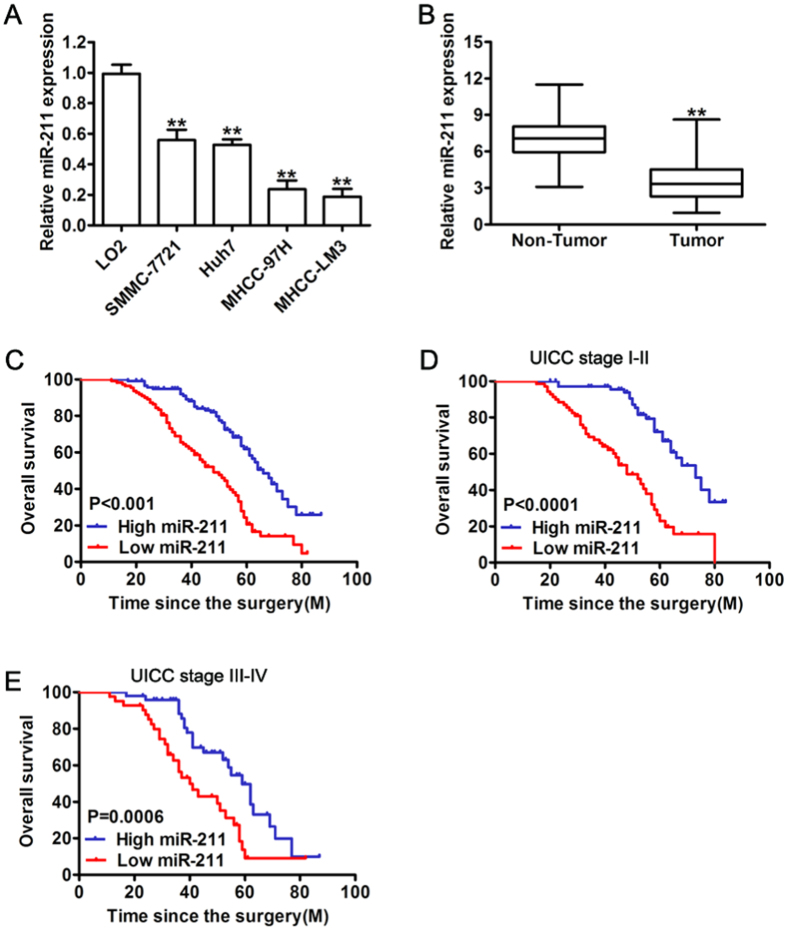
Down-regulation of miR-211 in HCC correlated with worse clinical outcomes.(A) miR-211 expression in indicated human HCC cell lines and immortalized human hepatic cell line (L02). (B) Relative expression of miR-211 in 227 pairs of HCC tissues (Tumor) and their corresponding adjacent non-cancerous tissues (Non Tumor). Expression levels of miR-211 were normalized to U6 expression. (C) Kaplan-Meier curve of correlation between the miR-211 level and overall survival of 2 groups of high (greater than the mean; n = 117) and low (less than the mean; n = 110) miR-211 expression levels in the primary tumors from 227 HCC patients. (D,E) Kaplan-Meier analysis of the survival of HCC patients according to their UICC stage: UICC I-II subgroup, UICC III-IV subgroup. **P < 0.01.